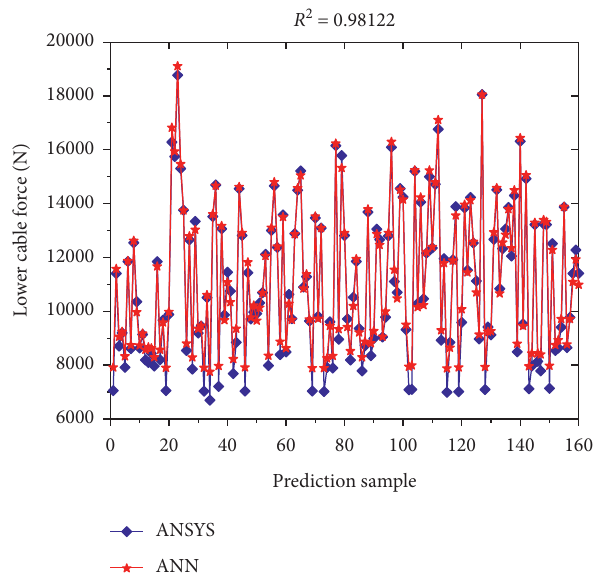
Figure 13: Comparison of prediction results of cable forces under suspension.